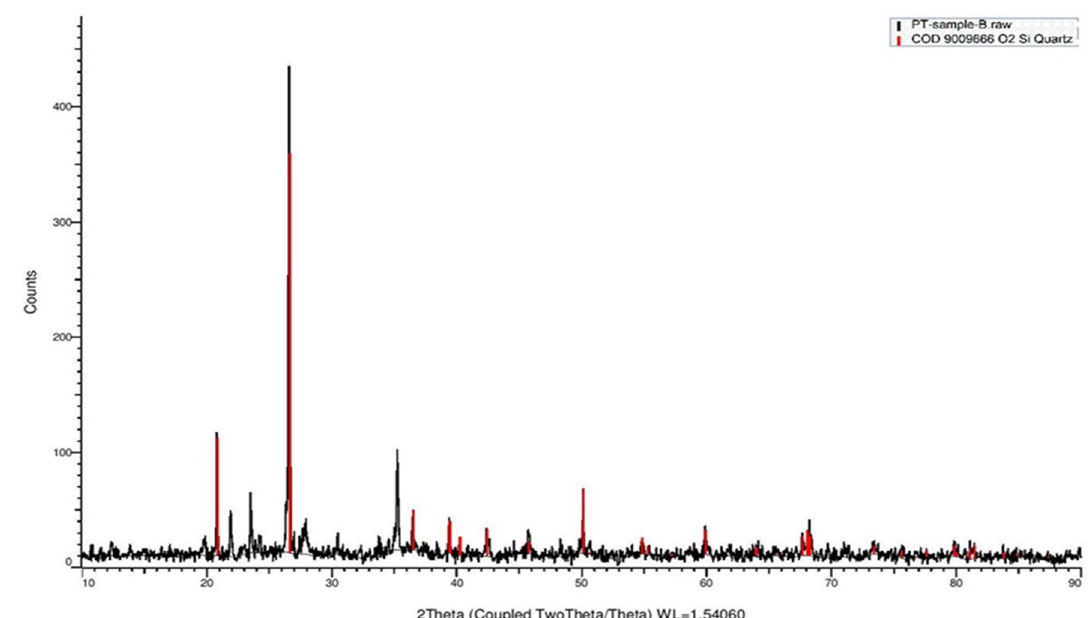
Fig. 1 XRD diffraction pattern of the powder reservoir rock sample